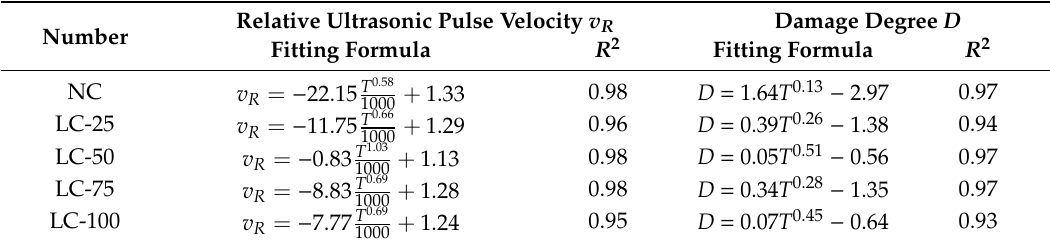
Figure 8. Relationship between ultrasonic parameters and temperature of concrete: ( a ) Relationship between relative ultrasonic pulse velocity and temperature; ( b ) Relationship between damage degree and temperature. Table 4. Fitting results of ultrasonic parameter and temperature of concrete.